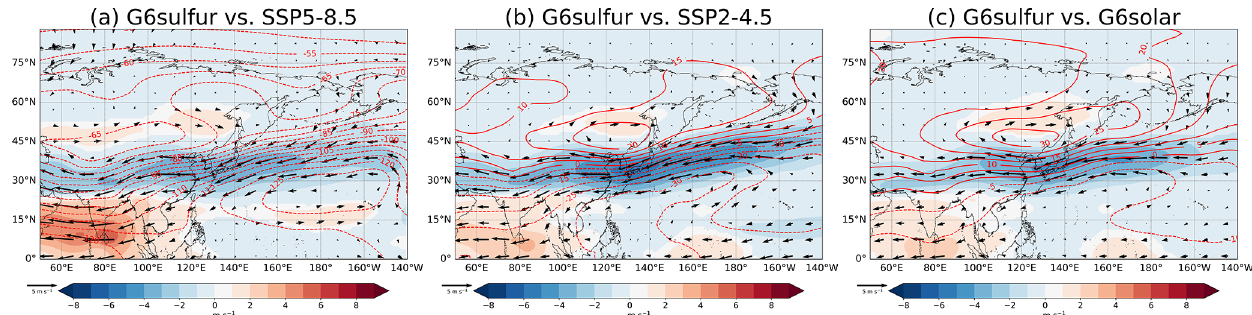
Figure 5. Differences in MJJAS mean geopotential thickness between 200 and 500hPa (red contours) and 200hPa winds (shaded for velocity and vectors for direction) for the future period of 2071–2100 between G6sulfur and SSP5–8.5 (a) and SSP2–4.5 (b) and G6solar (c)